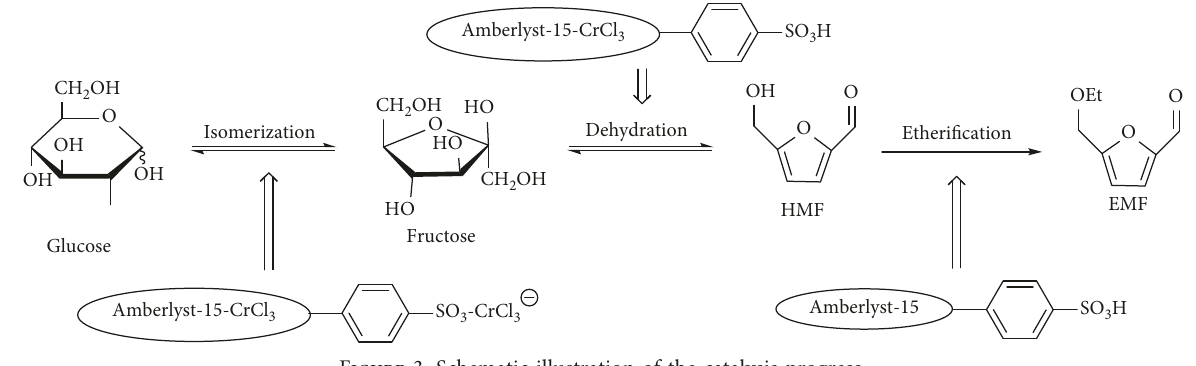
Figure 3: Schematic illustration of the catalysis